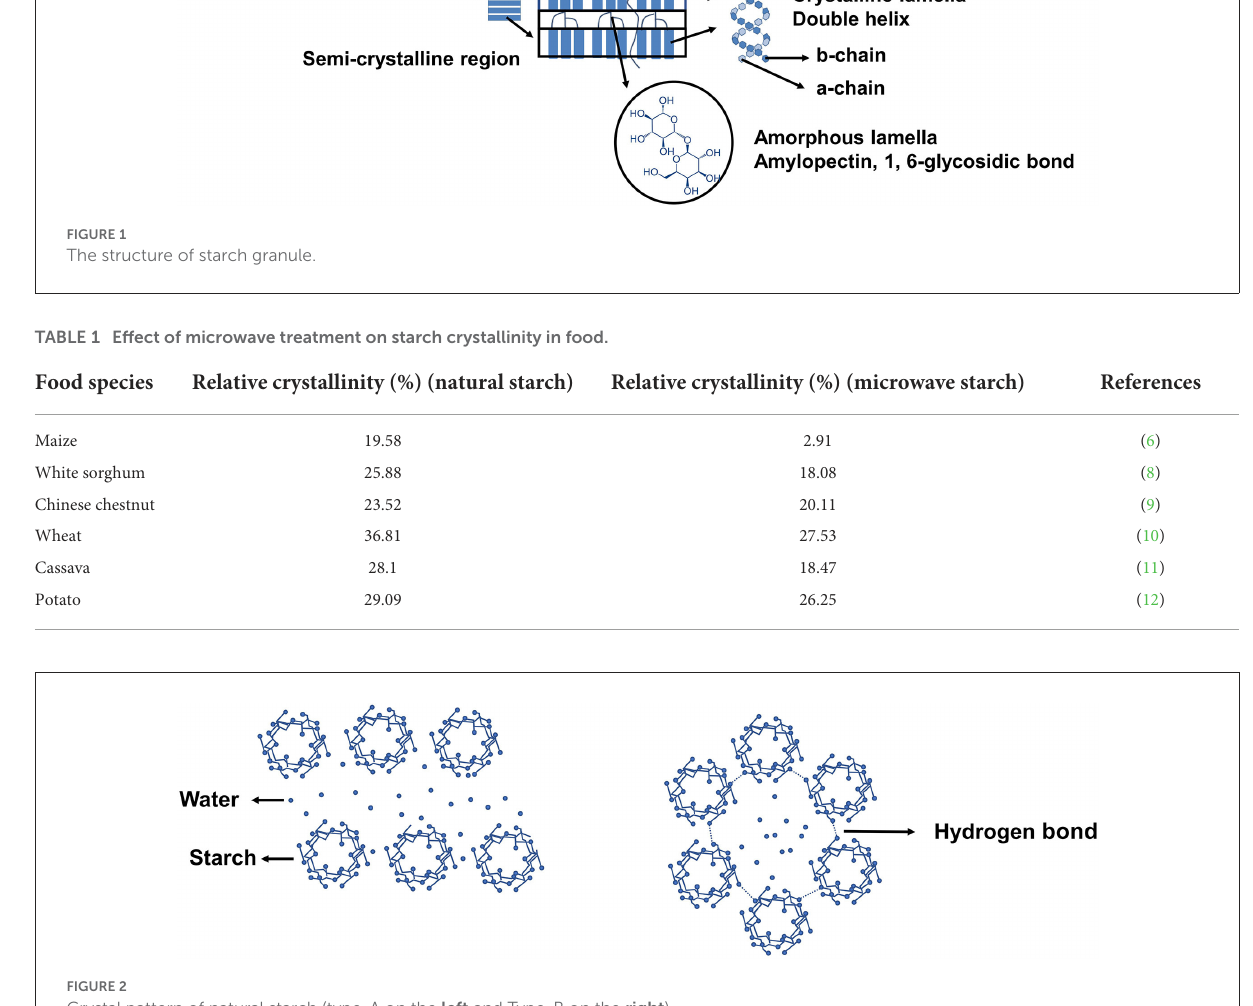
starch crystallinity varies with plant kinds from various